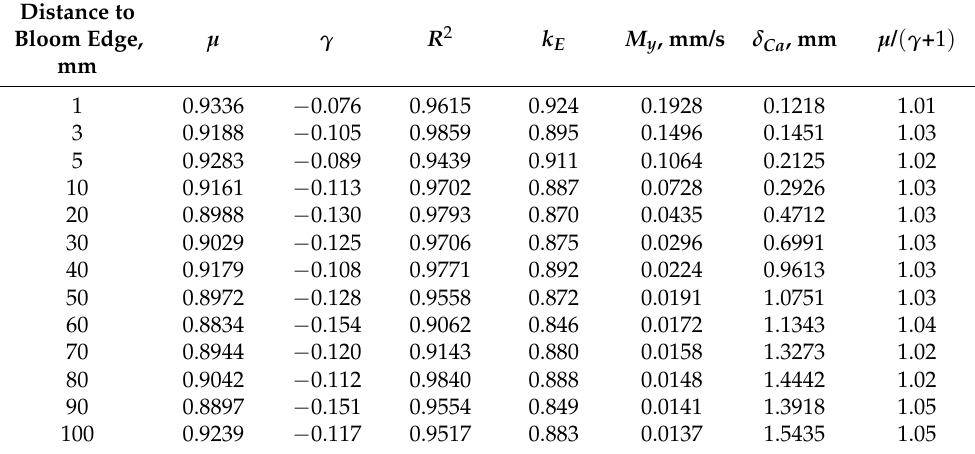
Table 4. Fitted and calculated results in the inner curve side under 35 ◦ C ( µ , γ are fitted coefficients in Equation (3), and R 2 is the corresponding determination coefficient. k E is the effective solute redistribution coefficient. M y is growth velocity magnitude in the solidification unit along the measuring line at each position. δ Ca is the average thickness of the concentration boundary layer). Distance to